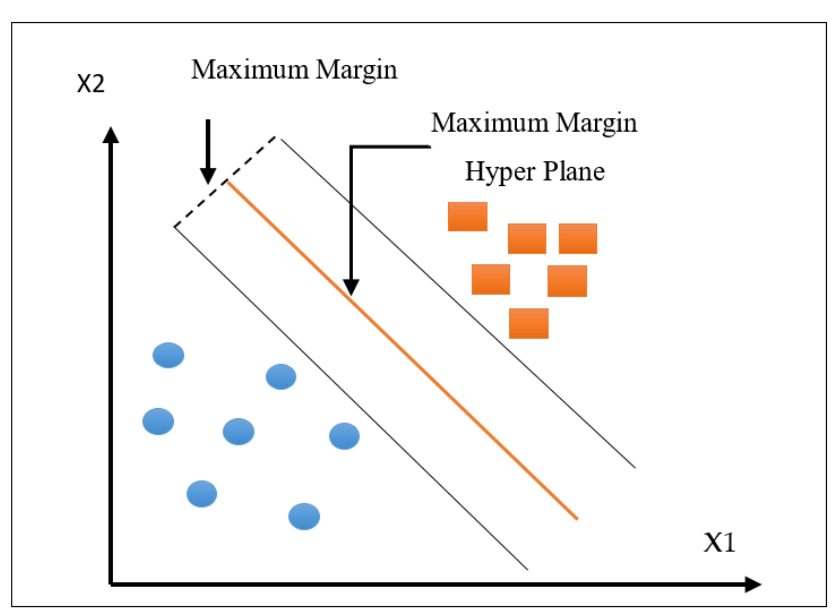
Figure 1. Support Vector Machine.